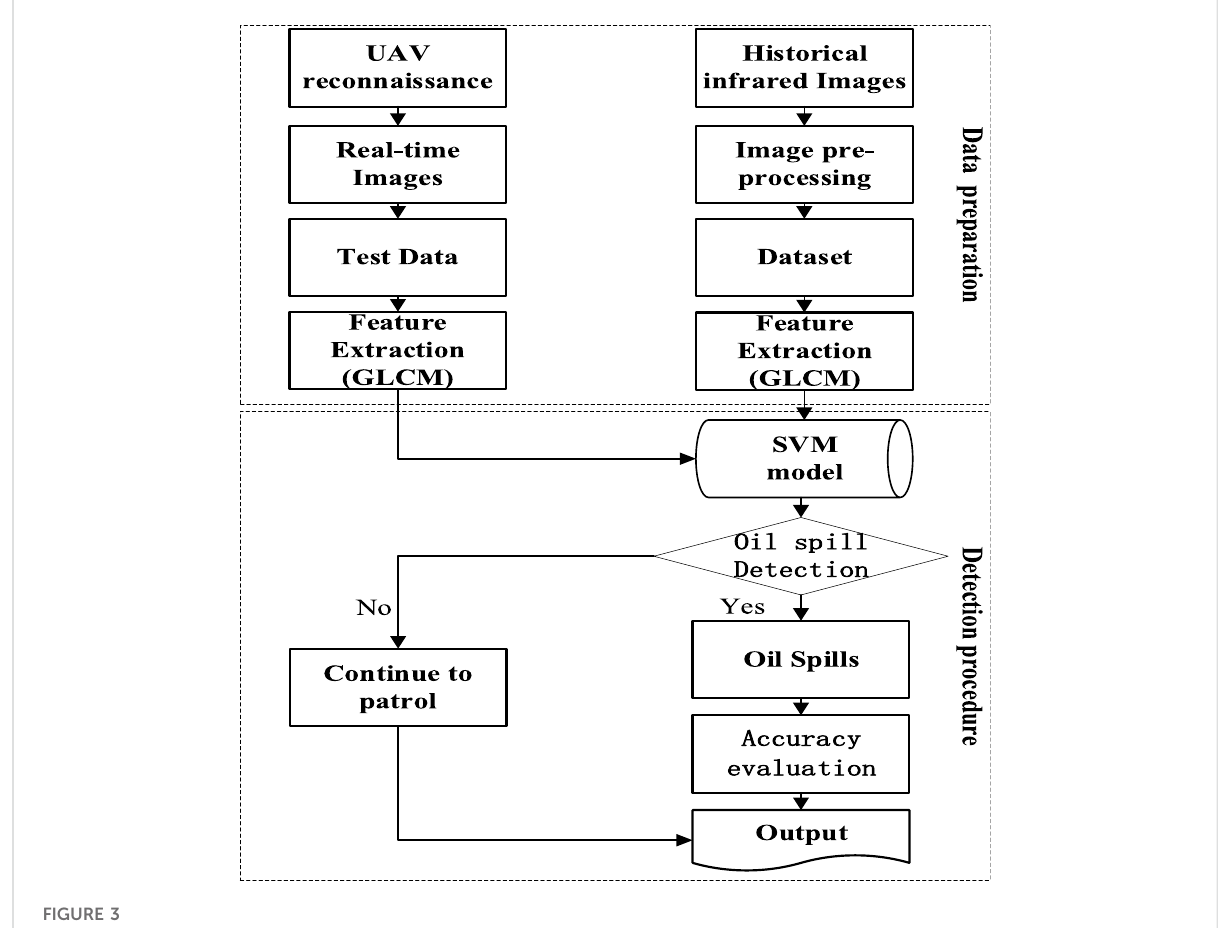
FIGURE 3 The technical route of the